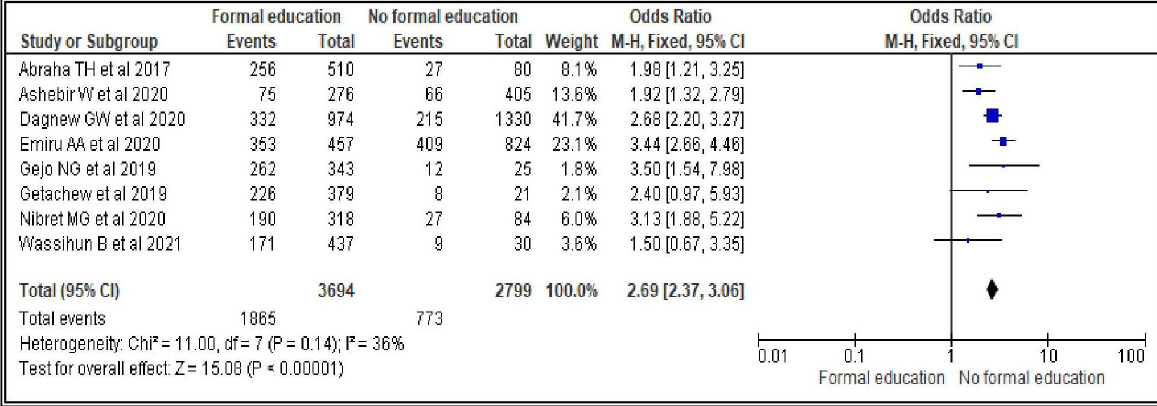
PLOS ONE | https://doi.org/10.1371/journal.pone.0270055 February 7,